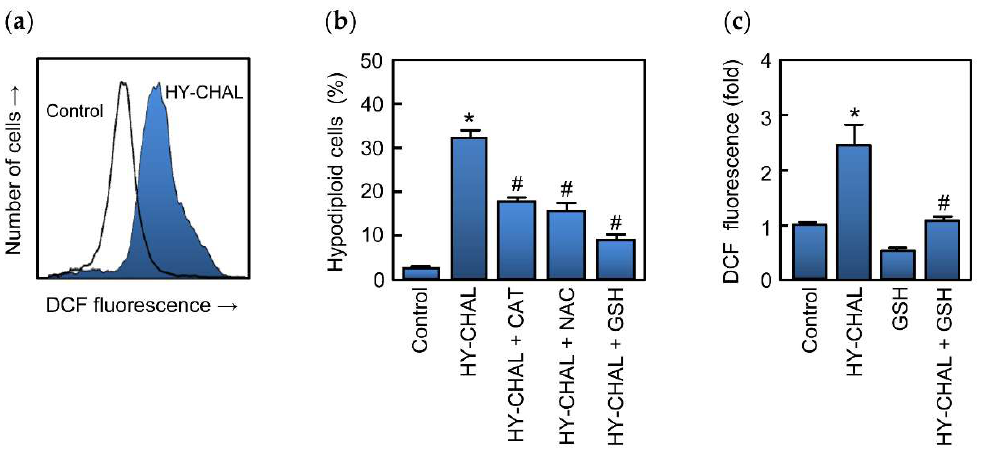
Figure 7. Role of ROS in HY-CHAL-induced cell death. ( a ) Representative histogram obtained by flow cytometry of the fluorescence of oxidized H 2 DCF after treatment of SK-MEL-1 with 3 µM HY-CHAL for 1 h; ( b ) Cells were preincubated with catalase (500 units/mL), N -acetyl-L-cysteine (5 mM), or glutathione (5 mM) and then treated with HY-CHAL (3 µM) for 24 h and thereafter the percentage of hypodiploid cells was determined by flow cytometry; ( c ) Fluorescence obtained by the oxidation of H 2 DCF of cells preincubated with glutathione (5 mM) for 2 h and then incubated with HY-CHAL (3 µM) as in ( a ). * Indicates p < 0.05, significantly different from untreated control. # Indicates p < 0.05, significantly different from HY-CHAL.